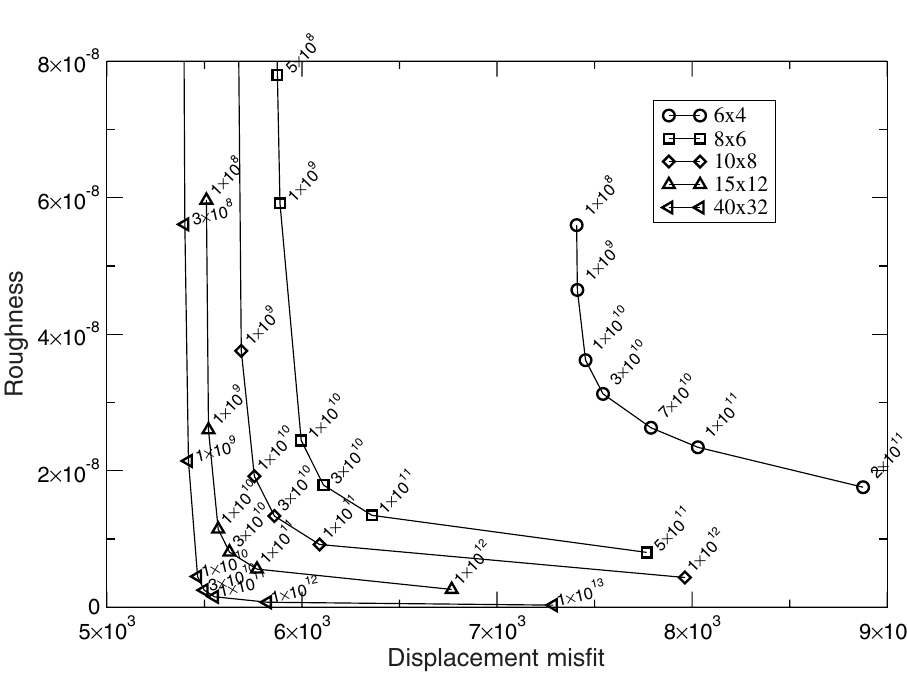
Fig. 9. Trade-off curves between the M 2 of LOS displacements and the roughness of the slip distribution, for different p × q-subfault models. Labels give the weight f of roughness in the cost